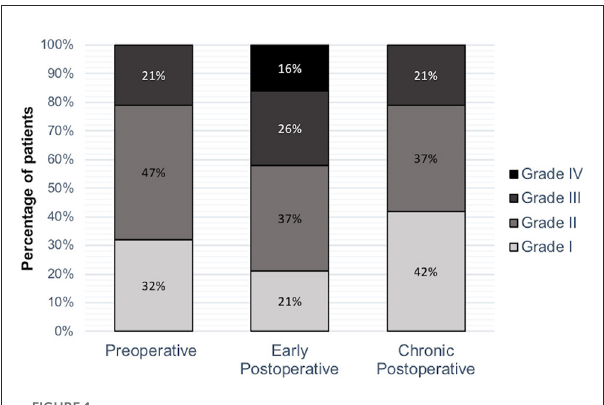
FIGURE1 Neurologic evaluation. MCCS value was measured pre and postoperatively and in the chronic postoperative evaluation. A significant difference emerged between early postoperative vs. postoperative chronic stage evaluation (p =